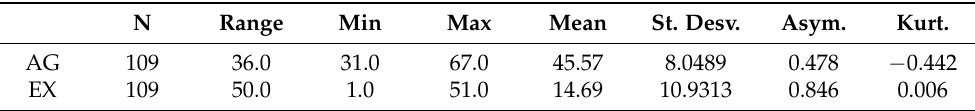
Table 2. Scale variables.